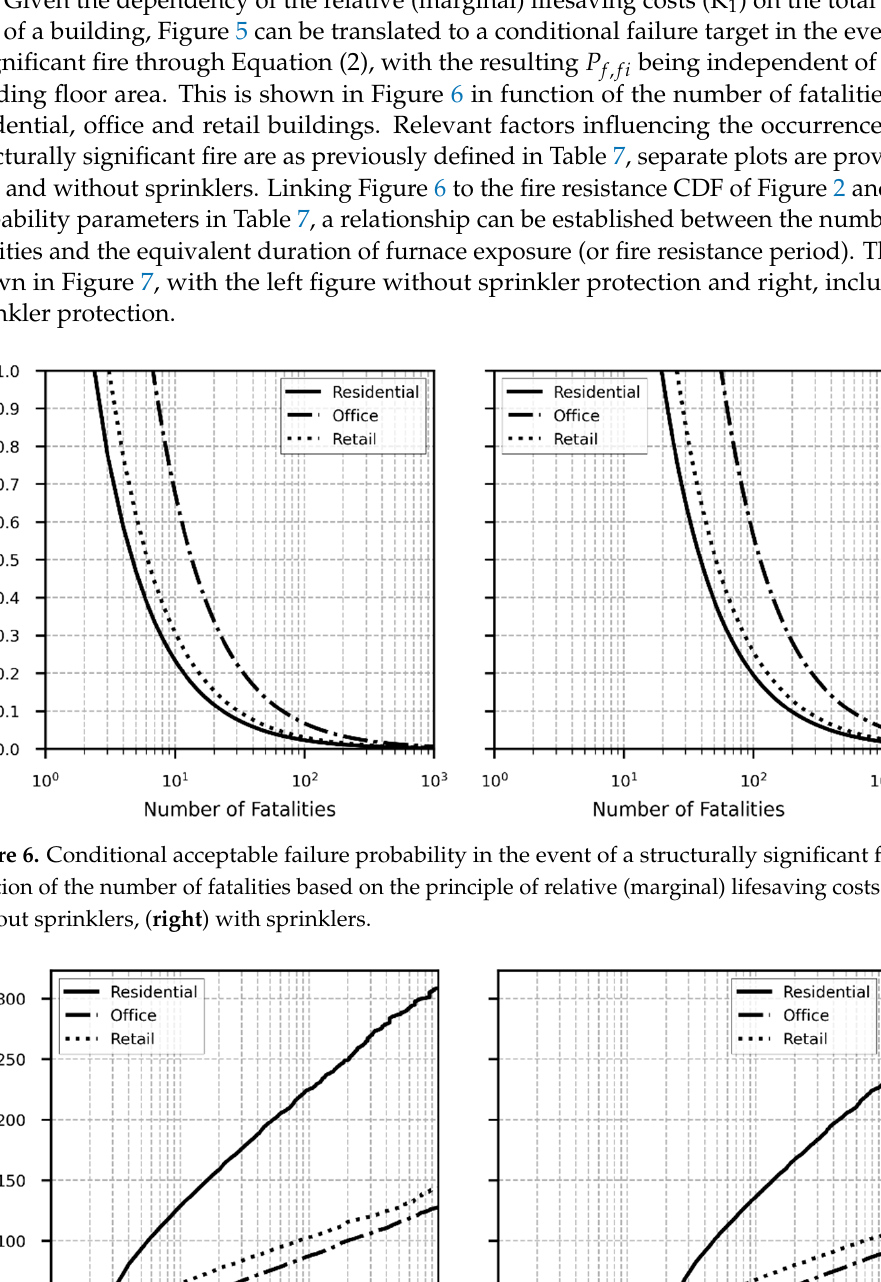
Figure 5. Acceptable failure probability in function of the number of fatalities and floor area, for residential, office and retail use.